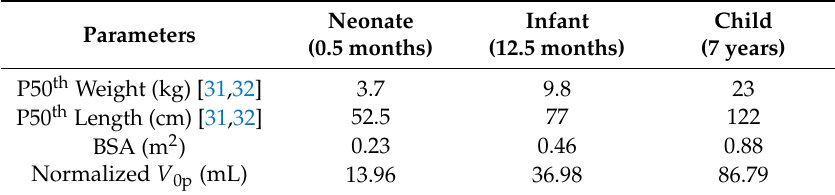
Table 2. Shared parameters to obtain the pediatric biopharmaceutics classification system (pBCS) classification. BSA, body surface